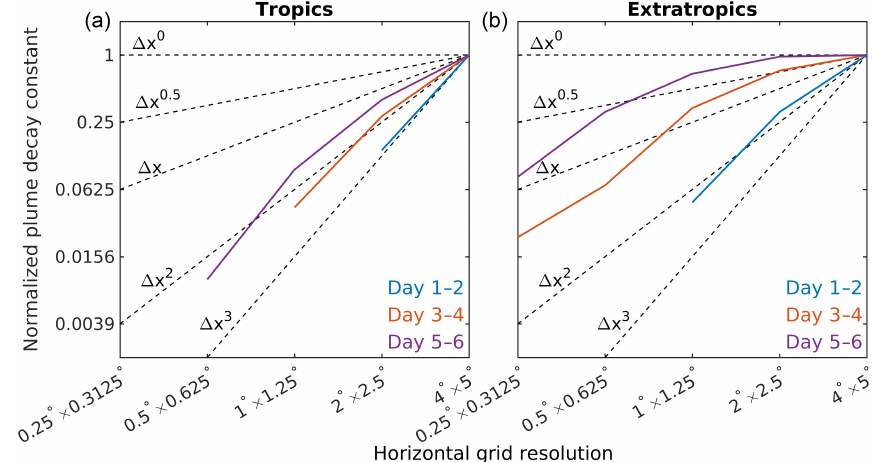
Figure 5. Sensitivity of plume decay to grid resolution and its dependence on plume age. At each resolution, the average value of the plume decay constant α for each 48h period is calculated and divided by the value at the coarsest resolution (4 ◦ × 5 ◦ ), resulting in the normalized decay constant shown as the ordinate. Results are shown for different plume aging times. The left-hand panel shows the average for the 36 plumes in the tropics, and the right-hand panel shows the average for the 54 plumes in the extratropics. The dashed lines show the order of improvement in the plume decay rate as a function of the grid resolution (cid:49) x , i.e. the effective order of accuracy of the advection scheme. Decay for tropical plumes at fine grid resolution is insignificant so that the plume decay constant is ill-defined and not shown on this figure. This is also true of decay at fine resolutions in the first 2 days for extratropical